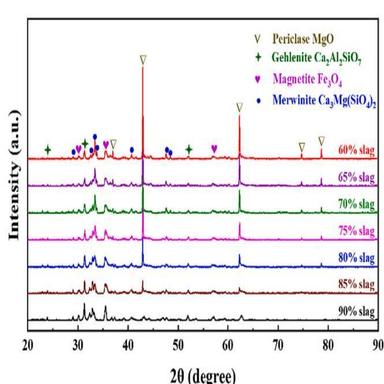
XRD patterns of samples after sintering at 1200 ◦C with different pretreated steel slag contents.